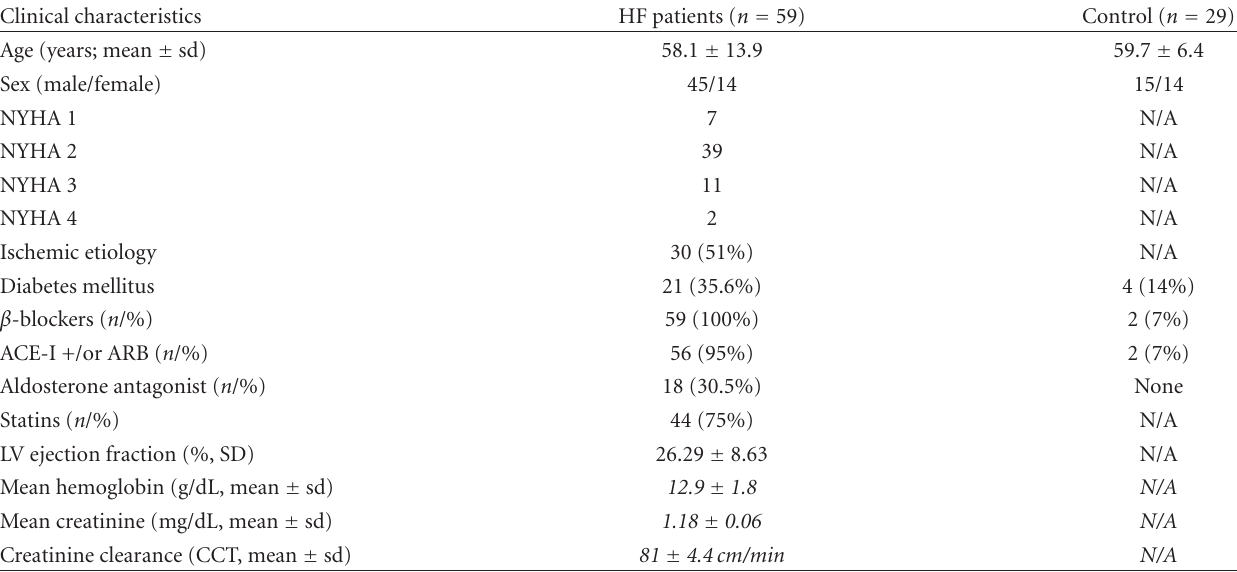
Table 1: Clinical characteristics of heart failure patients and controls.